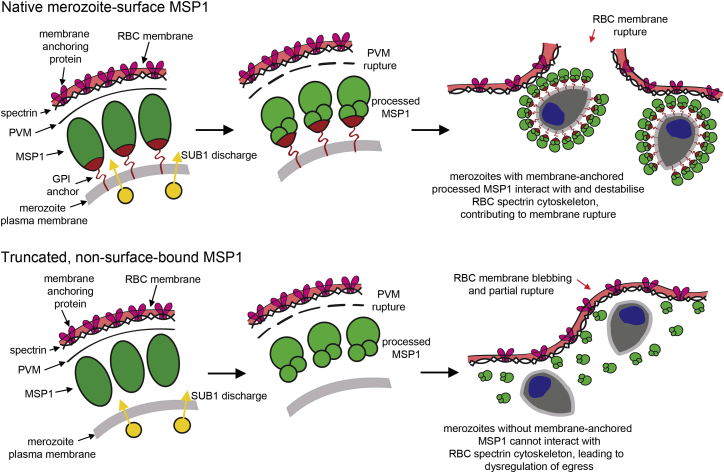
Model for the Role of MSP1 Processing in EgressSee also Movie S5.